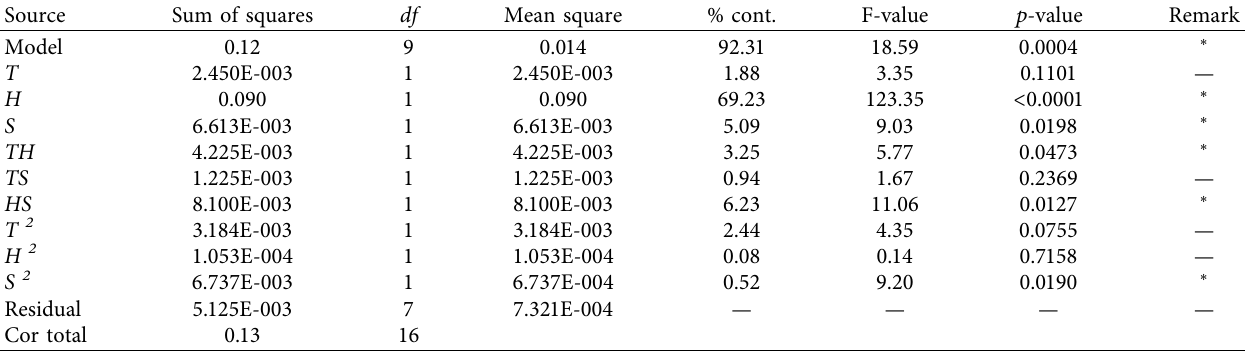
Table 3: ANOVA result of MOE.